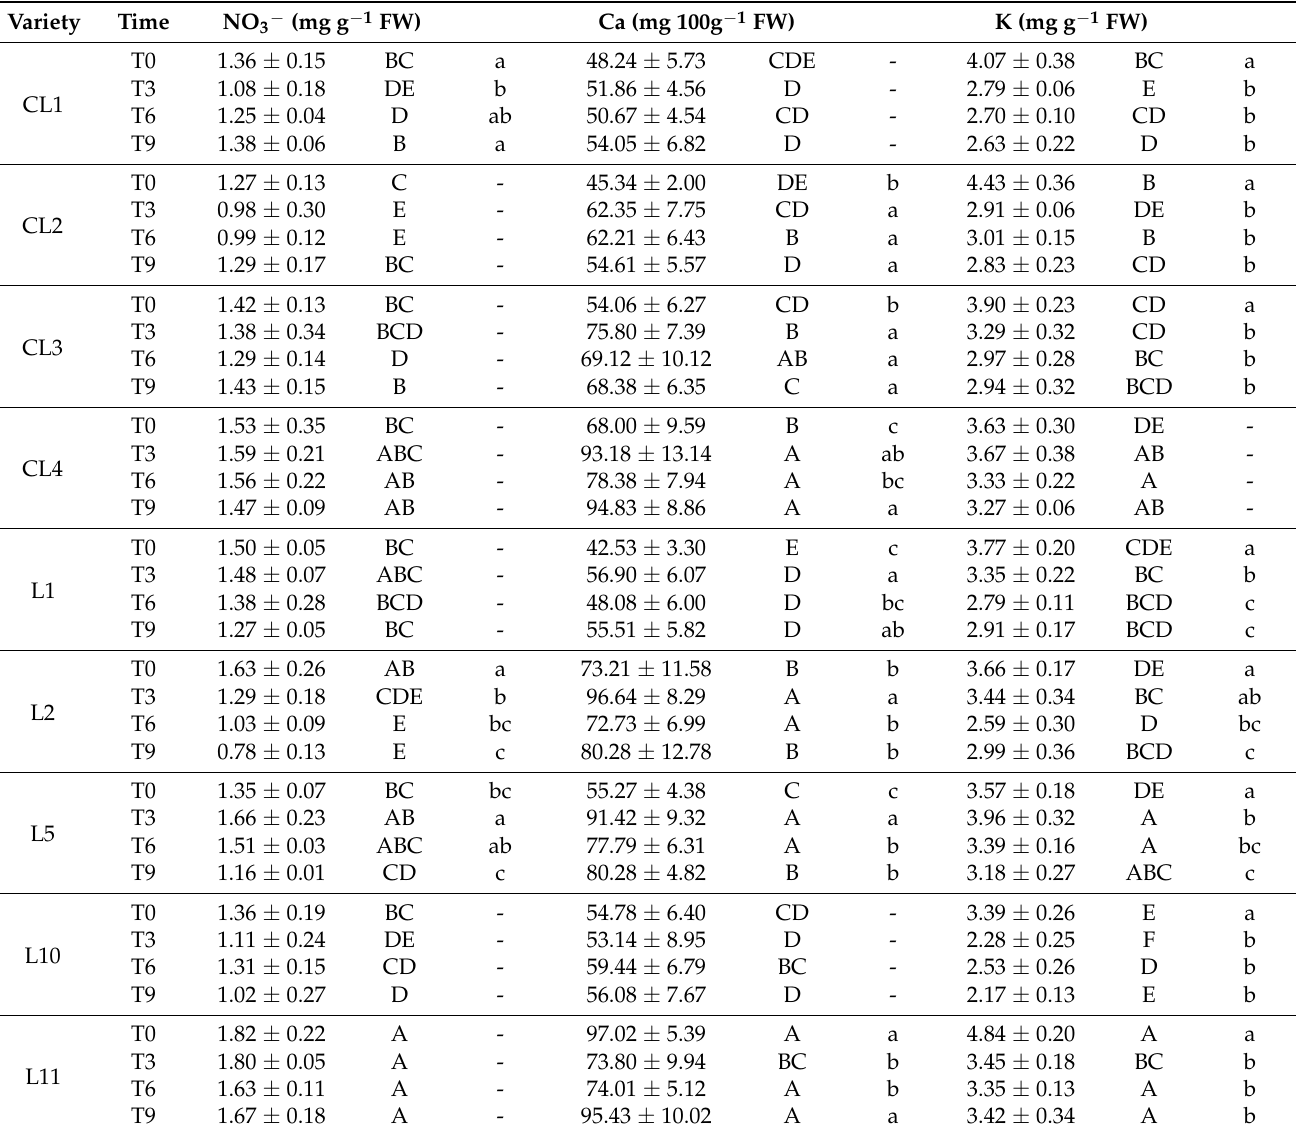
Table 5. Variation parameters for the quality traits in the nine harvested lettuce varieties measured at 0 (T0), 3 (T3), 6 (T6) and 9 (T9) days after conservation under chamber conditions. Values are the mean ± SE of four replicates per landrace. The mean is subjected to a one-way ANOVA. Different capital and lower case letters indicate significant differences between varieties and storage time, respectively, at p < 0.05 by the LSD test. Chl: Chlorophylls; Car: Carotenoids; Ant: Anthocyanins; Asa: Ascorbic Acid; Phe: Phenols; DPPH: Antioxidant capacity; H 2 O 2 : hydrogen peroxide; LP: lipid peroxidation; NO 3 − : nitrate; Ca: Calcium; K: